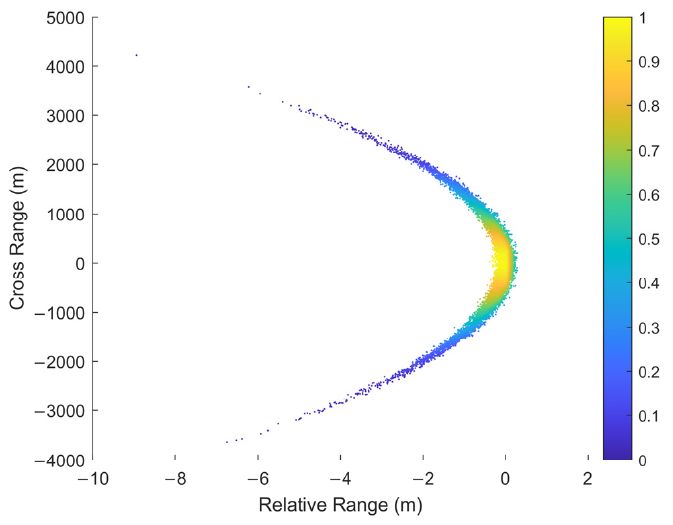
Figure 3. The CL Problem of Nonlinear Measurement.